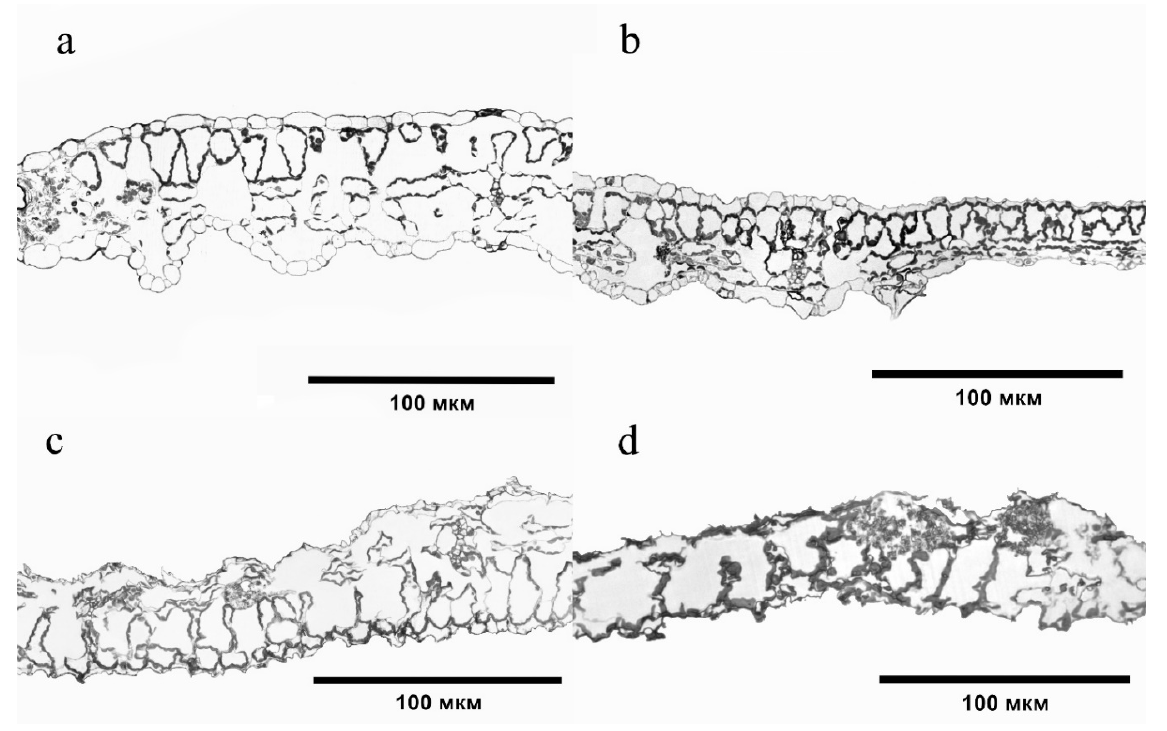
Figure 6. Cross sections of a Solanum lycopersicum leaf plate: ( a ) Control; ( b ) 20 MPC BaP; ( c ) 40 MPC BaP; ( d ) 60 MPC BaP.